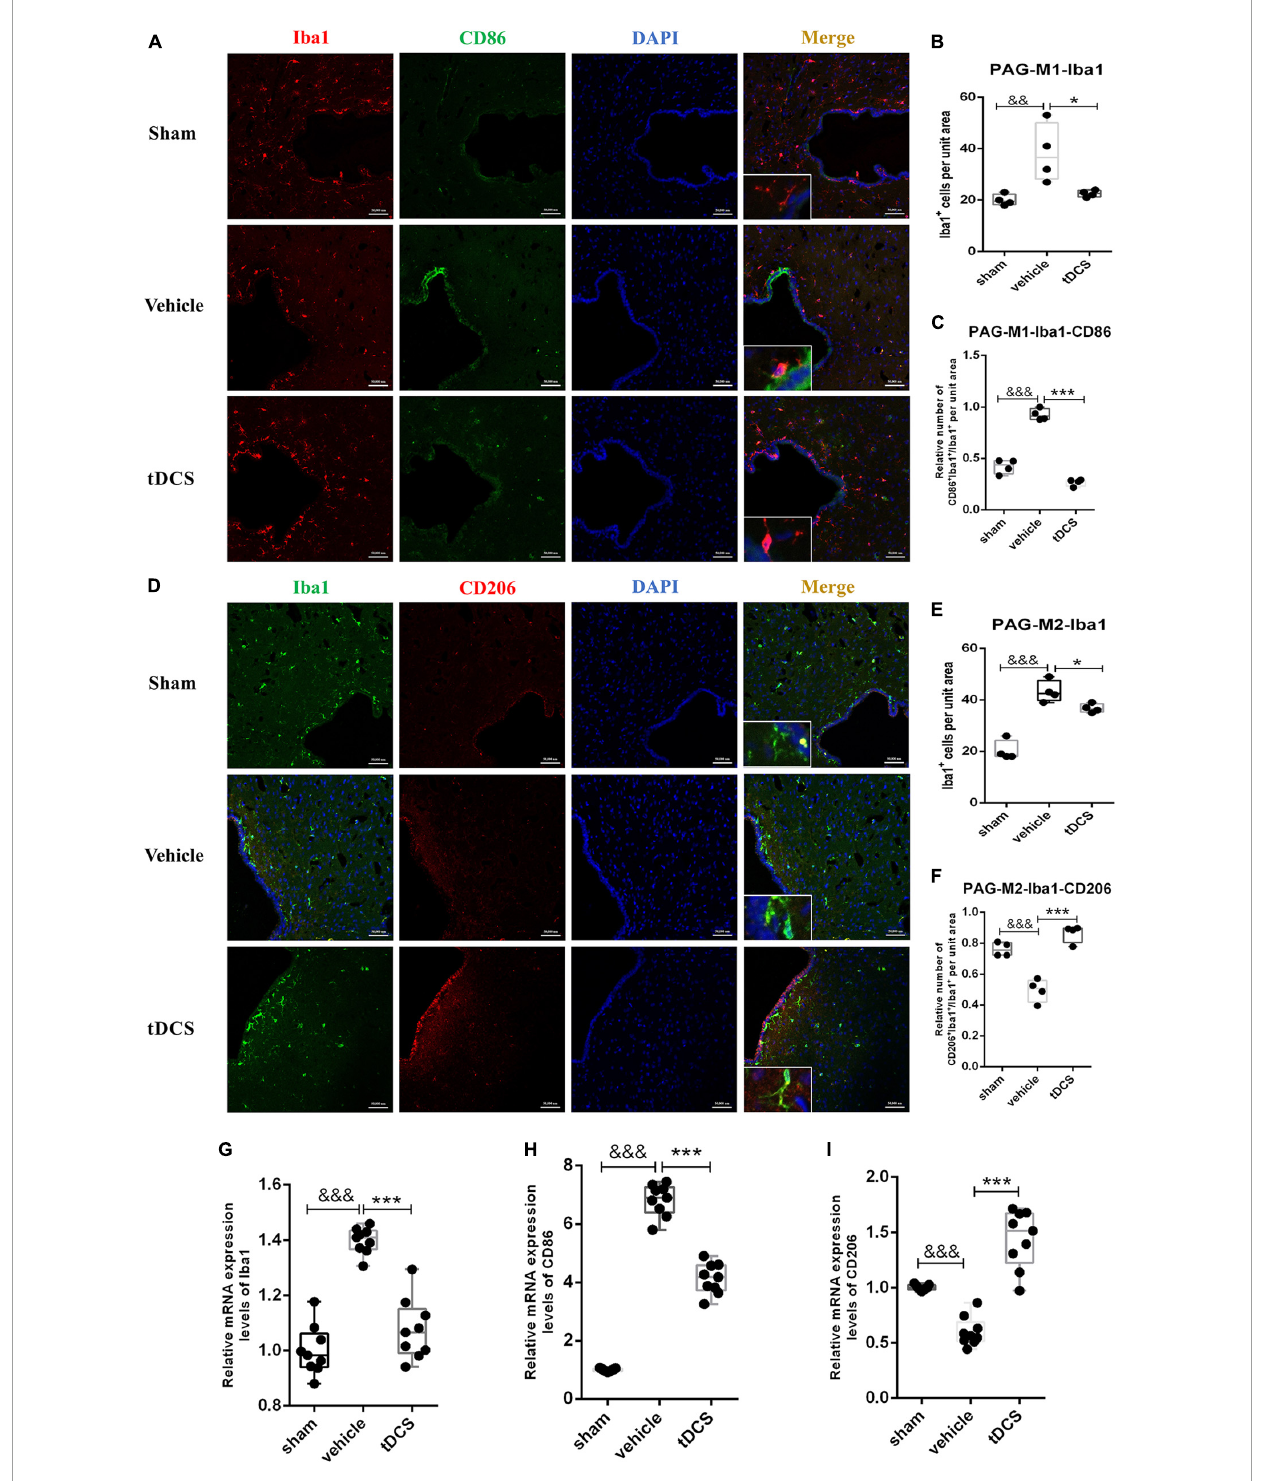
FIGURE5 tDCS alters microglial polarization direction in the midbrain PAG region. (A) Iba1 and CD86 protein immunofluorescence co-staining in three groups. Iba1 protein was stained with red fluorescence, and CD86 protein was stained with green fluorescence. nuclei were labeled with blue fluorescence. Merged pictures show positive cells. Bar = 50 µ m. (B) Statistical analysis results of the expression of Iba1 in microglia of each group. (C) Statistical analysis results of the proportion of CD86 and Iba1 positive cells to Iba1 positive cells in microglia of each group. (D) Iba1 and CD206 protein immunofluorescence co-staining in three groups. Iba1 protein was stained with green fluorescence, and CD206 protein was stained with red fluorescence. Nuclei were labeled with blue fluorescence. Merged pictures show positive cells. Bar = 50 µ m. (E) Statistical analysis results of the expression of Iba1 in microglia of each group. (F) Statistical analysis results of the proportion of CD206 and Iba1 positive cells to Iba1 positive cells in microglia of each group. (G–I) Relative mRNA expression levels of Iba1, CD86, and CD206 in each groups, as detected by qRT-PCR. Vehicle group vs. sham group, &&& p < 0.001 and && p < 0.01; tDCS group vs. vehicle group, *** p < 0.001 and * p < 0.05, n =